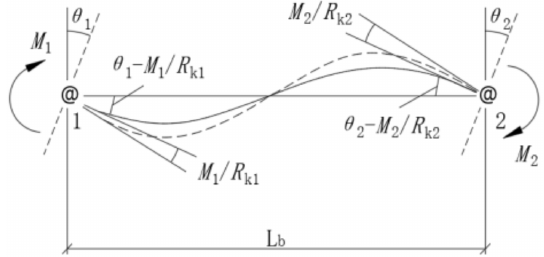
Figure 5. Semirigid restraint bars at both